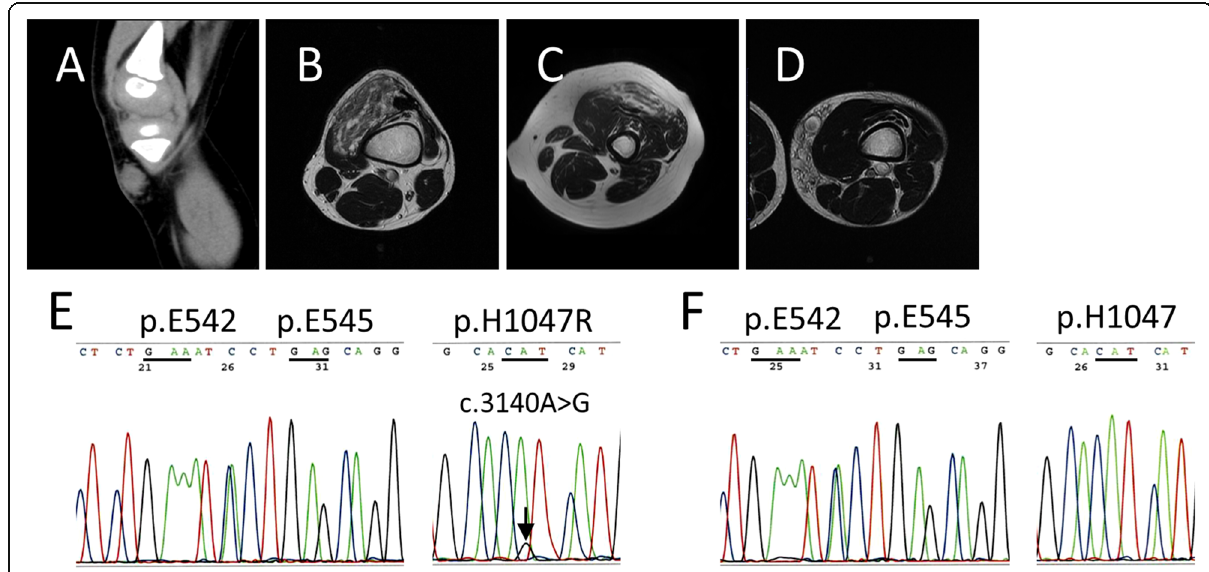
Fig. 1 A-D Computed Tomography (CT) or magnetic resonance image (MRIs) analysis. Sagittal CT image of case 1 ( A ), and axial T2-weighted MRI of case 2 ( B ), case 3 ( C ) and case 4 ( D ). E, F DNA sanger sequencing of hotspot mutations in PIK3CA. Sequencing of PIK3CA for each FAVA cases showing chromatograms for c.3140 A>G (p.H1047R) ( E ) or wild-type ( F